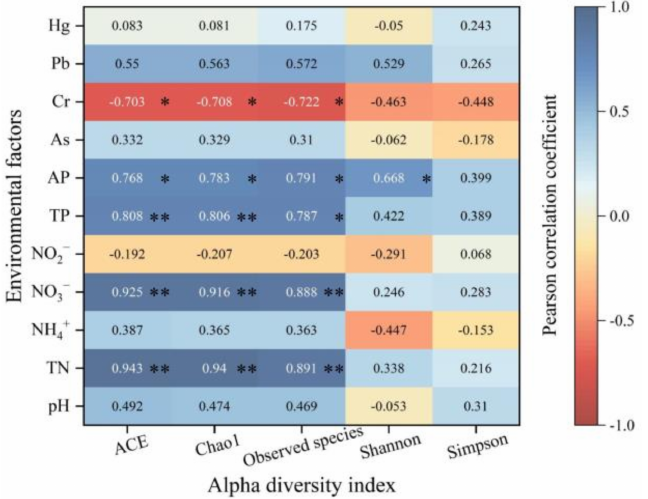
Figure 4. Pearson correlation analysis between environmental factors and α -diversity index of bacte- rial community in sediments. (Note: * indicates significant correlation at 0.05 level and ** indicates significant correlation at 0.01